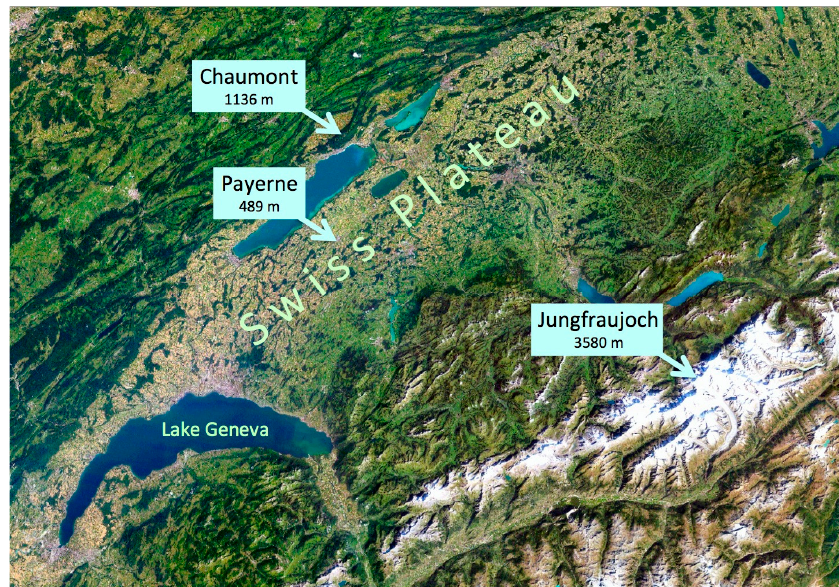
Figure 2. Location of the three stations constituting the altitudinal gradient. The distance between Chaumont and Payerne is 26 km; between Payerne and Jungfraujoch, it is 85 km. The background shows a satellite (Landsat) image mosaic of the western half of Switzerland [14].